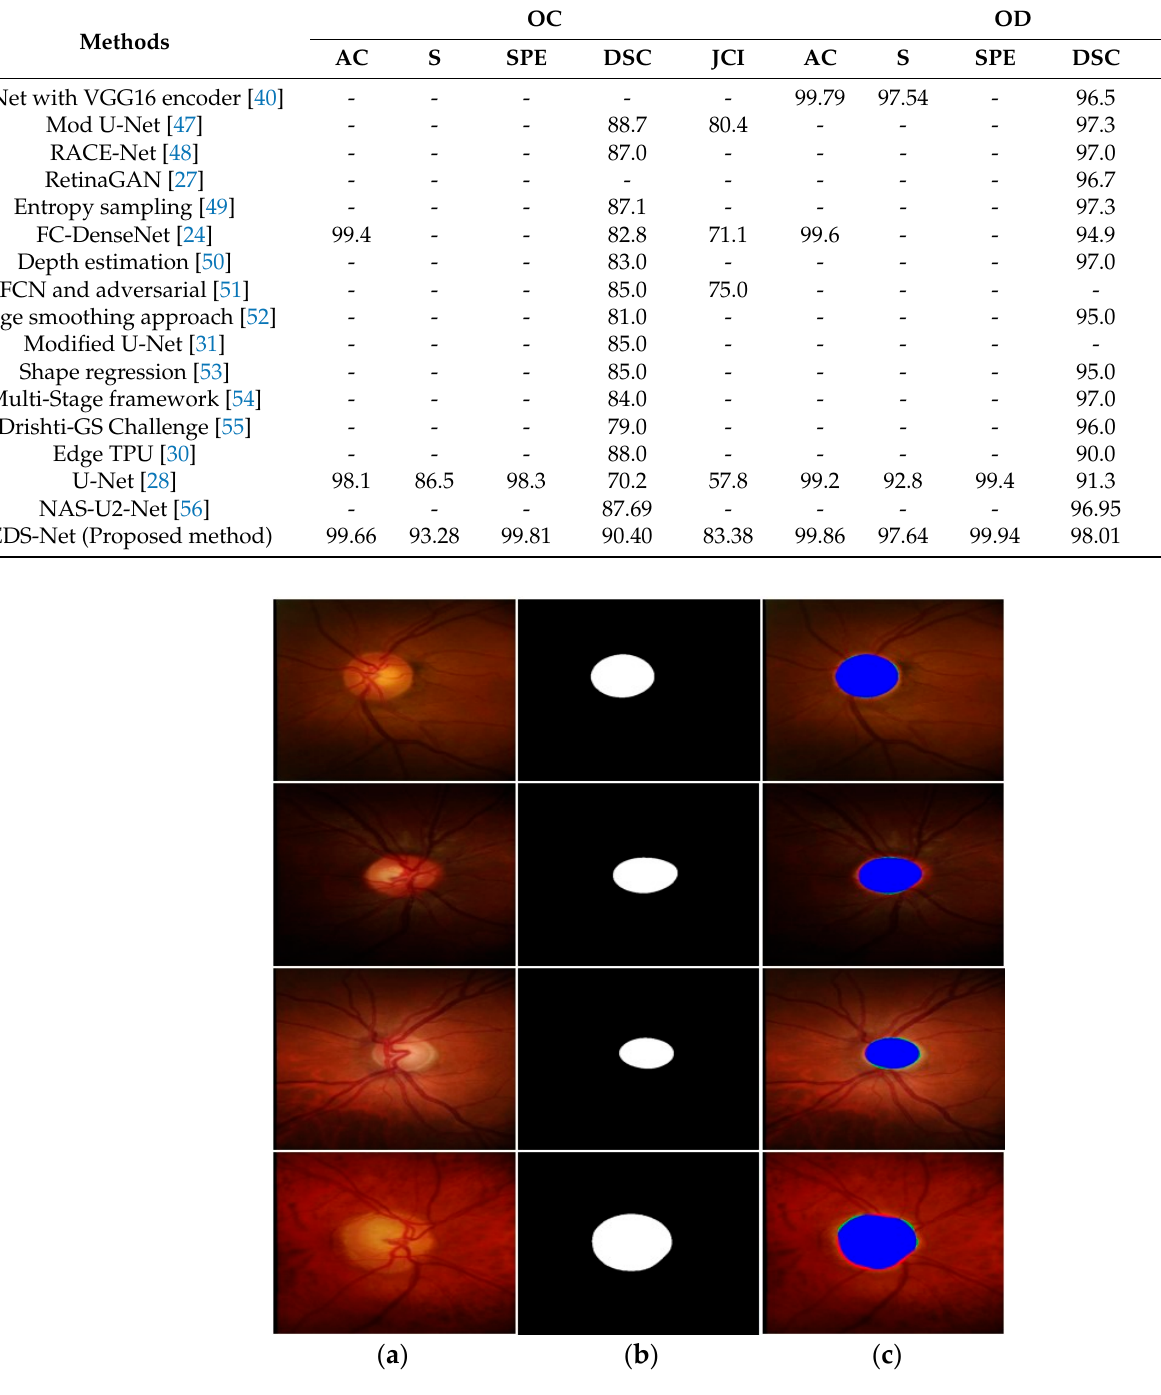
( c ) Figure 11. Good OC segmentation qualitative results on the Rim-One-r3 database, attained by applying FEDS-Net. ( a ) Input image, ( b ) corresponding groundtruth image, and ( c ) segmented